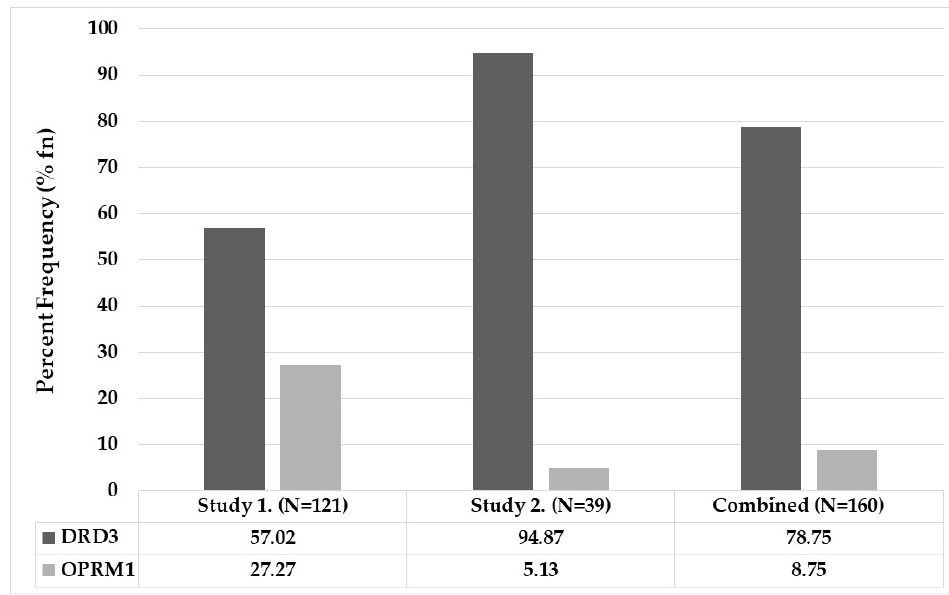
Figure 2. Percent frequencies of DRD3 and